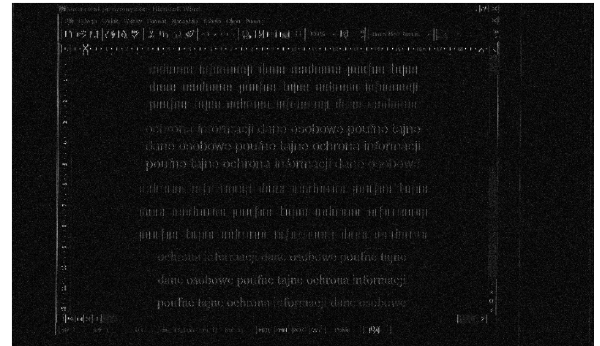
Figure 23. Image reconstructed based on sensitive emissions measurement on frequency 640 MHz ( BW = 50 MHz, the size of characters-14 points), from the top: secure symmetrical font, Arial font, secure asymmetrical font, Times New Roman font (VGA standard).